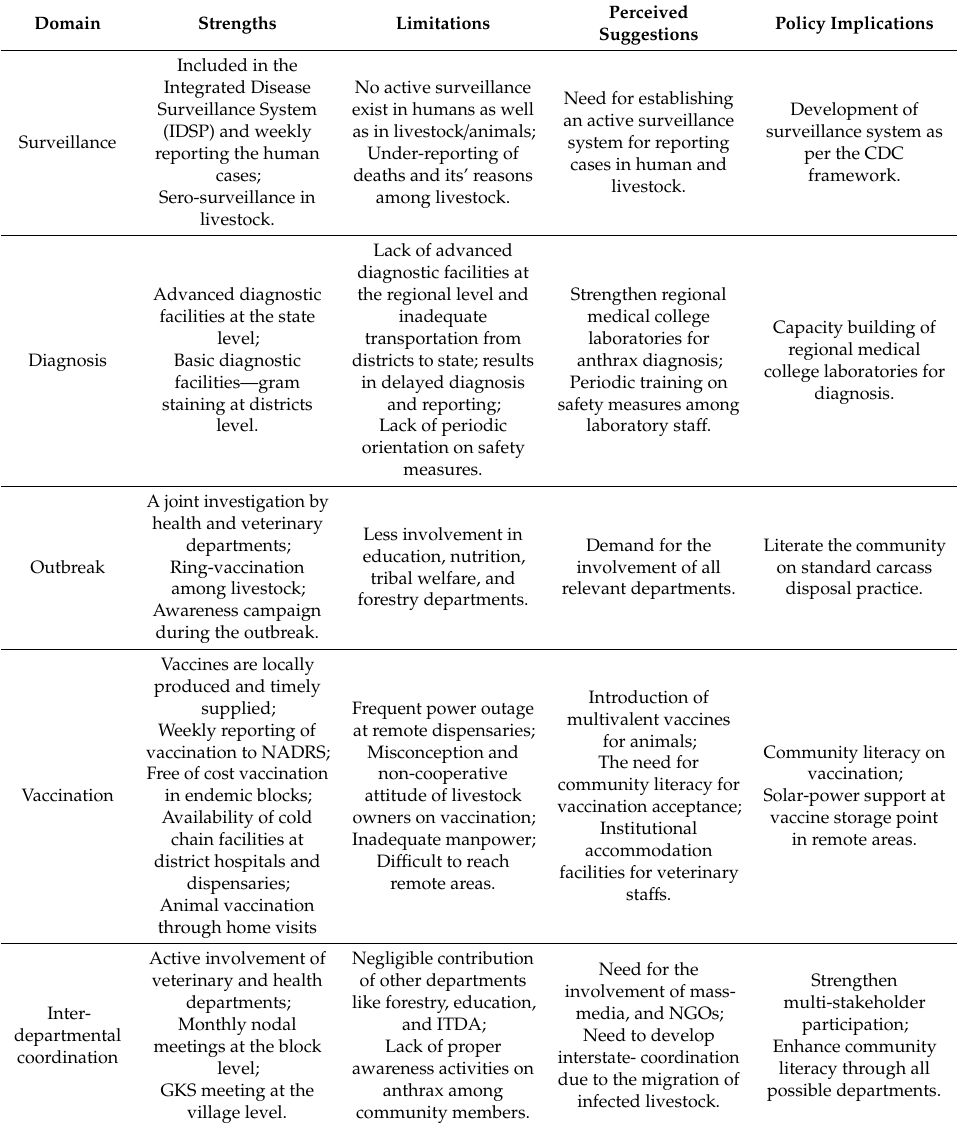
Table 4. Summary of findings—Strengths, limitations, perceived suggestions, and policy